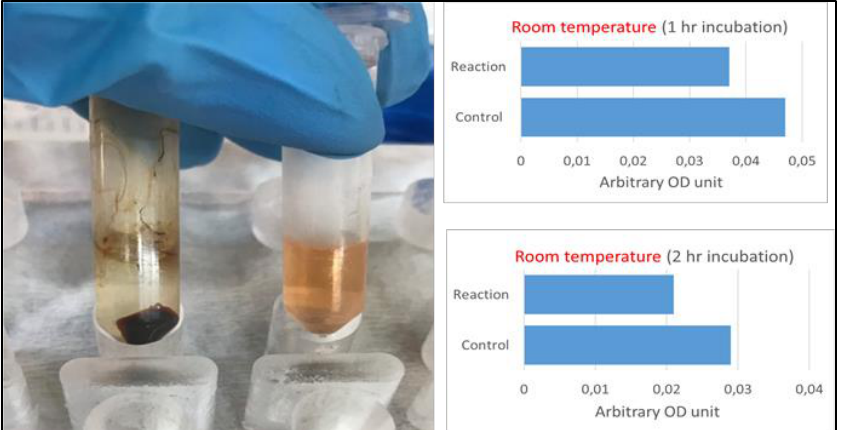
Figure 5. Effect of incubation time (1 & 2 h) at room temperature and 250 µ g of magnetic nanoparticles on the recovery of carotenoids from H. pluvialis extracts prepared using CO 2 supercritical fluid extraction and ethanol as solvent. Spectrophotometric data are presented using arbitrary units to indicate solution absorbance (also known as Optical Density, OD). Charts on the left report the OD of control and reaction samples (pellet acetone eluted). Table 3. Astaxanthin and lutein concentration (mg/mL) for control, S1 and S2 samples.